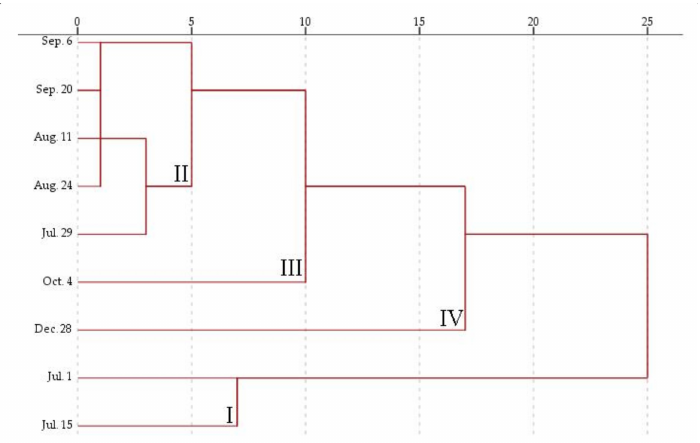
Figure 3. Dendrogram estimating contents of phenolics and triterpenoids in lingonberries based on their collection date. Assignments I-IV indicate cluster